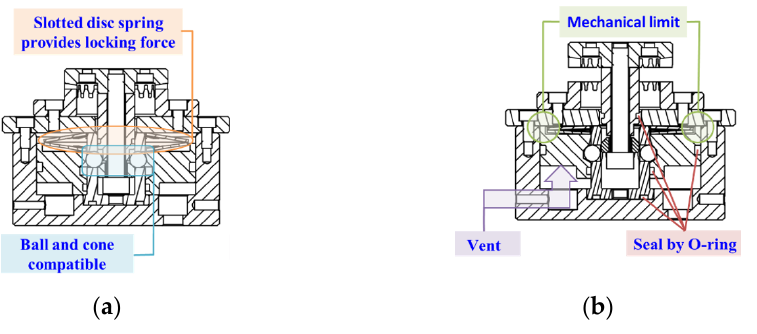
Figure 2. The internal structure of the designed fixture. ( a ) Locking state; ( b ) unlocking separation status.